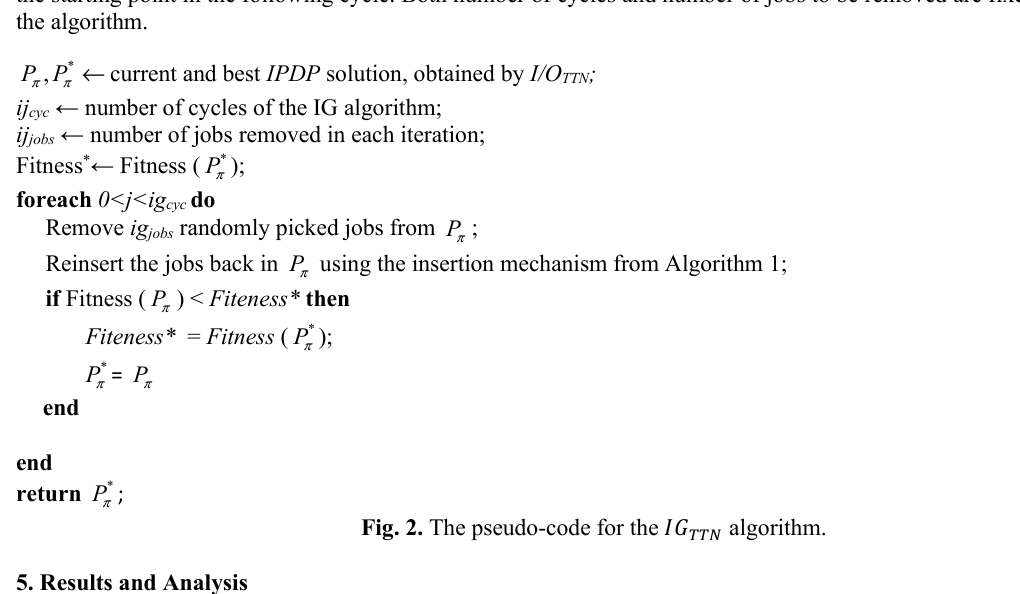
(cid:3021)(cid:3021)(cid:3015)